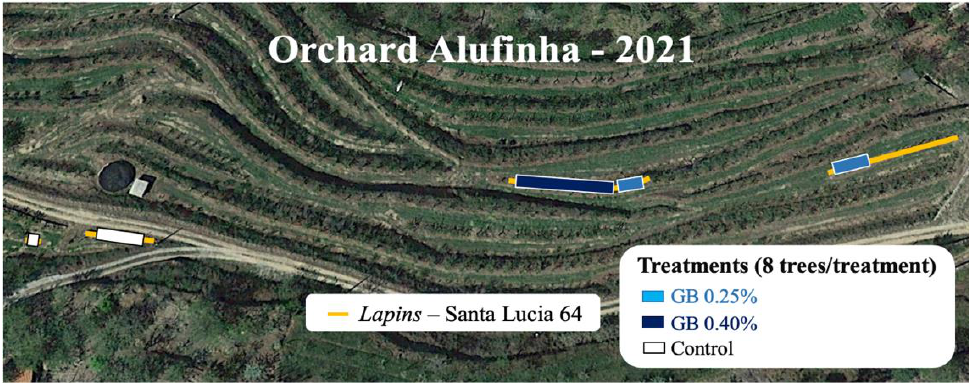
Figure 6. Commercial sweet cherry orchard in Alufinha, Resende.